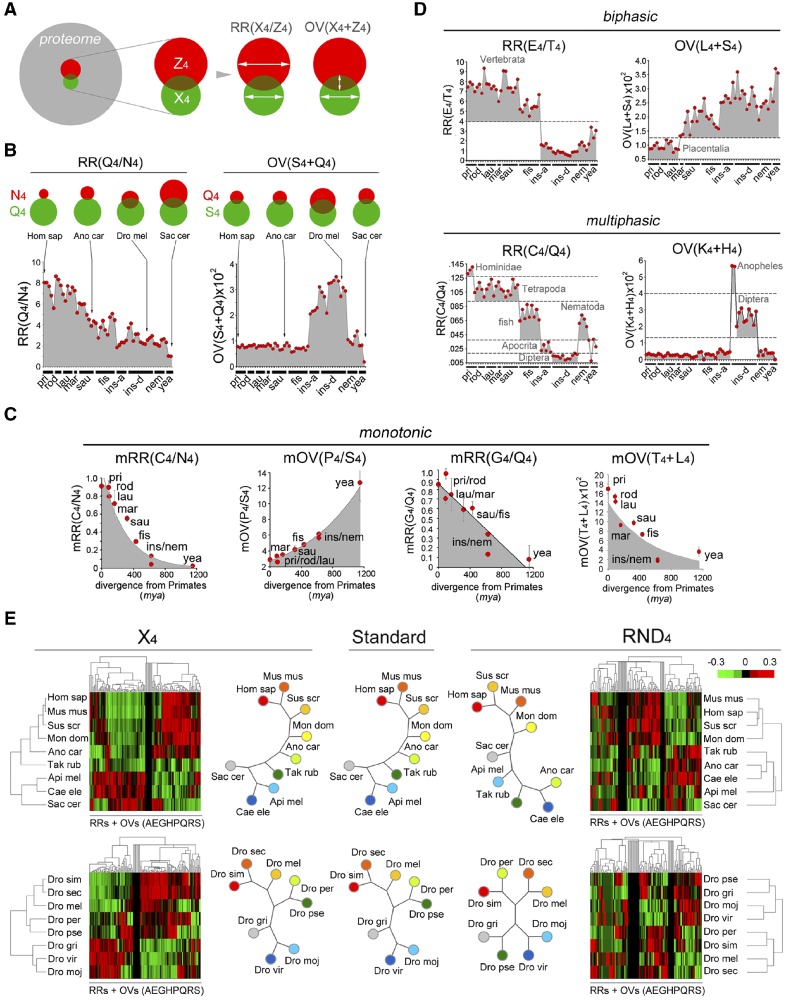
—Compound variation and combination trends of AARs encode evolutionary markers. (A) Venn diagrams representing how RR and OV parameters are calculated in each proteome. The large gray circle represents a given proteome and the red and green circles represent sets of proteins bearing two different AARs, X4 and Z4. The overlap area between the two circles represents proteins bearing both repeats. The RR(X4/Z4) parameter is calculated by dividing %X4 by %Z4. The OV(X4+Z4) parameter is calculated as the proportion of proteins containing a X4 repeat that also contain Z4 normalized to %X4 (Pelassa et al. 2014). (B) Sample plots of RR and OV parameters in individual species of the indicated taxa. Ins-a and ins-d indicates Apocrita and Diptera insects, respectively. Red dots indicate individual species from Homo to Saccharomyces (listed in the Materials and Methods section in the same order as they appear in the graphs). Light gray highlights groups of species for which the indicated parameters exceed 0. Sample Venn diagrams for selected species, graphically normalized to the size of the green circle, are shown above the graphs. (C) Graphs of the mean RR and OV parameters (± SEM), in the indicated taxa, that vary with monotonic trends (highlighted by trendlines and gray shading) with increasing divergence times from Primates. (D) Upper row. Graphs plotting RR and OV parameters with biphasic evolutionary trends that is, in which a given threshold value of the parameter identifies one or more taxa. Light gray highlights groups of species for which the indicated parameters exceed 0 or the thresholds indicated by dashed lines. Lower row. Graphs showing RR and OV parameters with multiphasic evolutionary trends. (E) Upper row. Cluster analyses of the RR and OV parameters derived from A/E/G/H/P/Q/R/S AARs (%X4) or from the corresponding control RND4 tetrapeptides, in the indicated species from Saccharomyces to Homo. Unrooted phylogenetic trees derived from the dendrograms of the cluster analyses are reproduced in the central diagrams, together with the unrooted tree reproducing the standard phylogeny. Note how the trees derived from X4 parameters reproduce the known phylogenetic relationships between the indicated species. Lower row. Same analysis as in the upper row for Drosophila species.